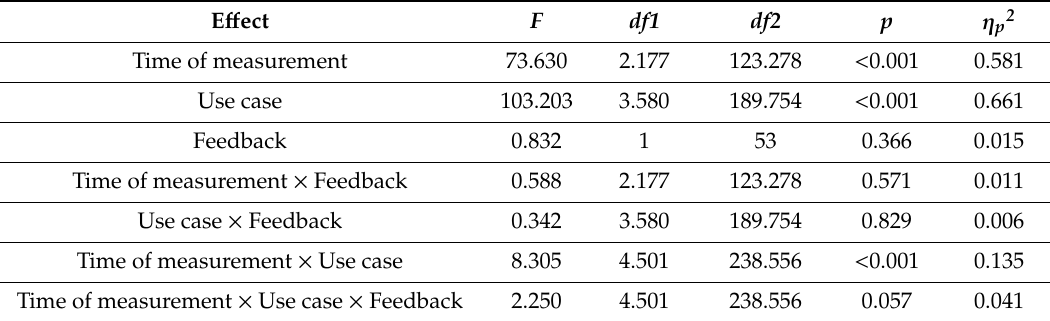
Table 4. Inferential statistics (i.e., F , df1 , df2 , p , η p2 —value) of time on